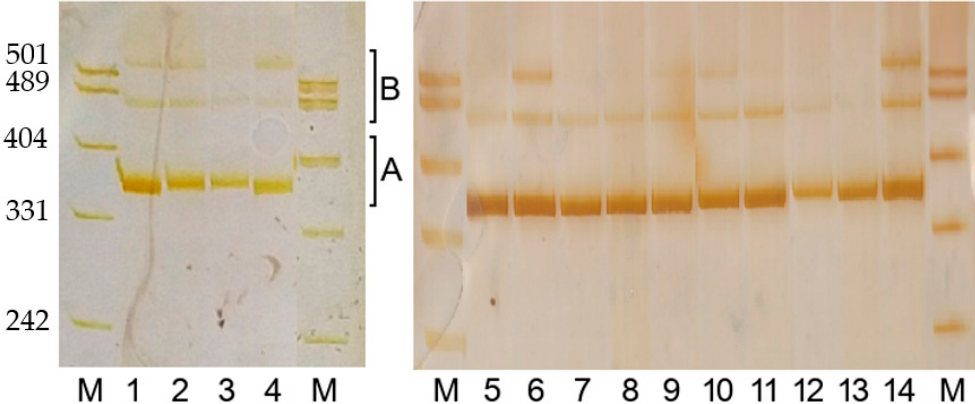
Figure 4. PCR product differences between cultivars carrying allele Gli-B1b in their genotypes 1, Gabo; 2, Bezostaya-1; 3, Mironovskaya-808; 4, Marquis; 5, 6, Gabo; 7, 8, 9, Marquis; 10, 11, Bezostaya-1; 12, 13, 14, Mironovskaya-808. M, marker pUC19/Mspl, with DNA fragment lengths in bp given on the left-side of the figure.